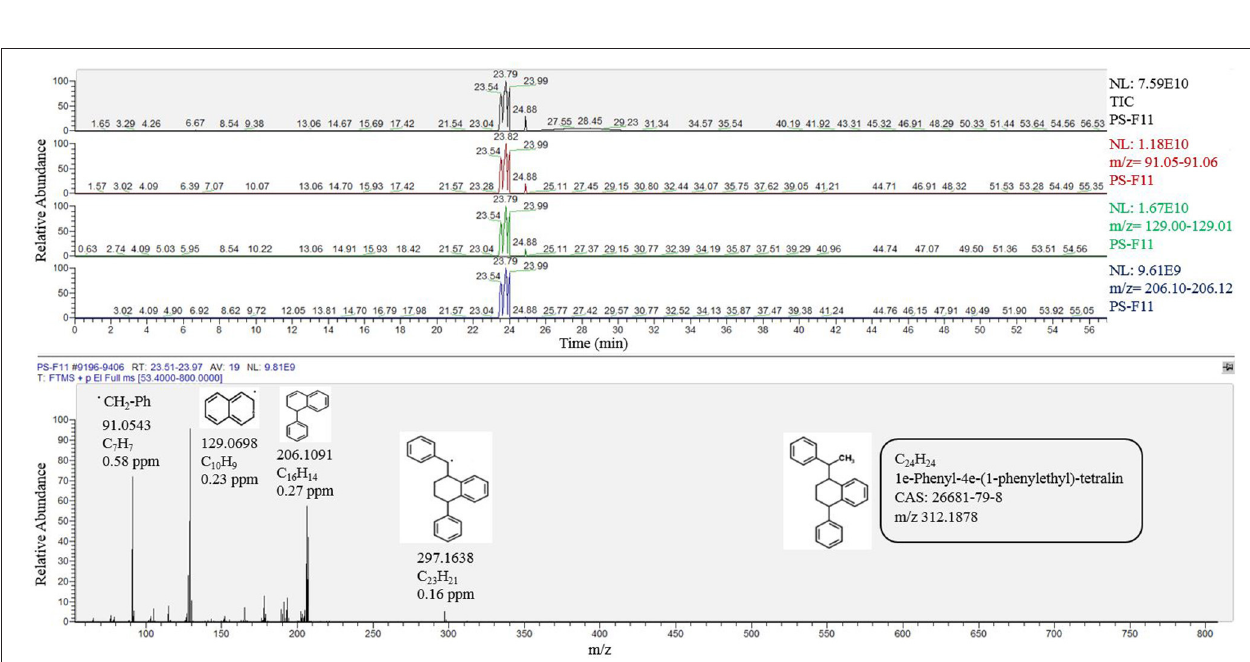
FIGURE 4 | Total ion chromatogram (TIC) and extracted masses of fragment ions of 1e- Phenyl- 4e- (1- phenylethyl)-tetralin (top) and mass spectra for 1e- Phenyl- 4e- (1- phenylethyl)- tetralin (bottom) in HIPS fraction 11.